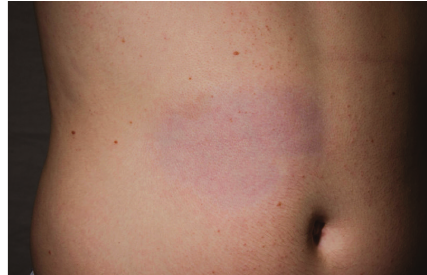
Figure 1: Plaque-type morphea.